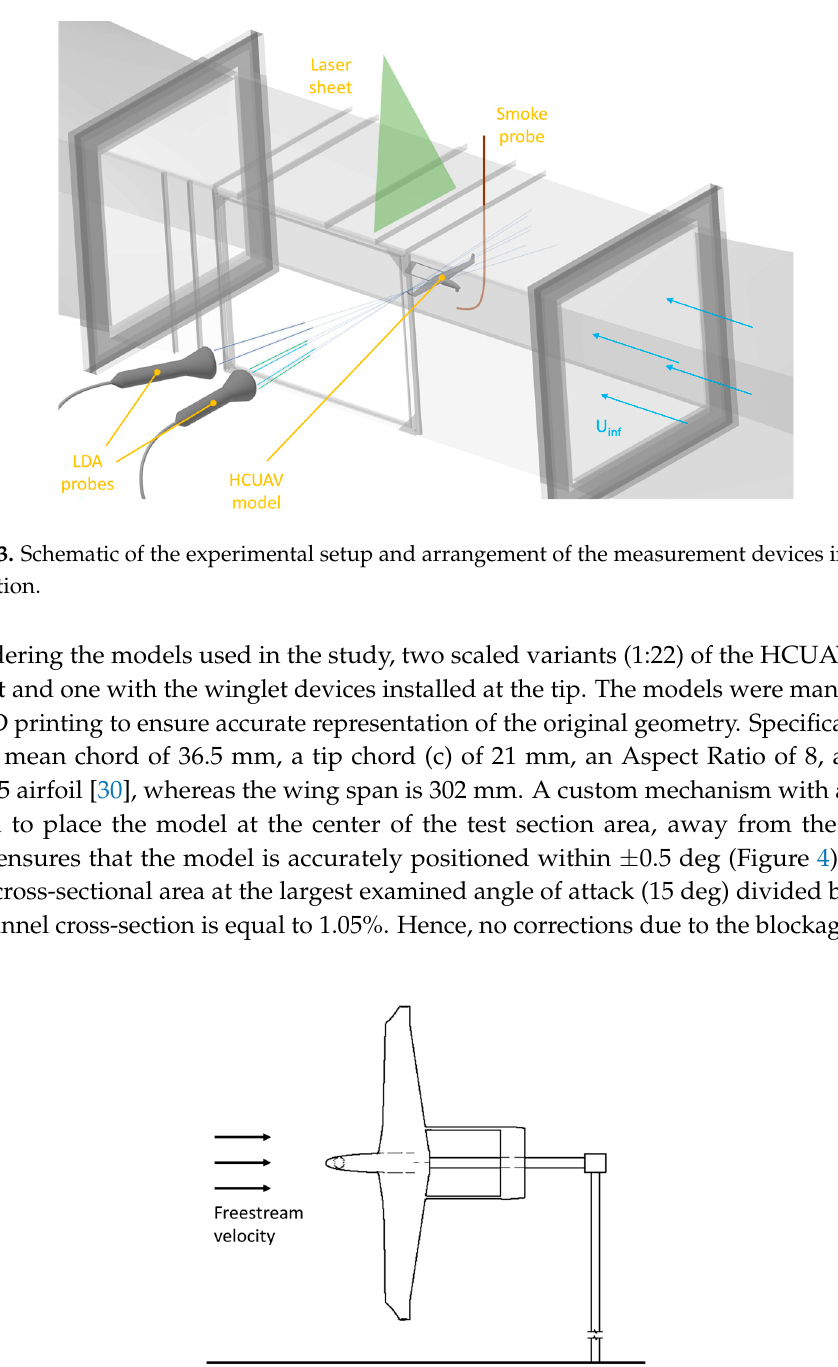
Figure 4. The HCUAV model inside the windtunnel.